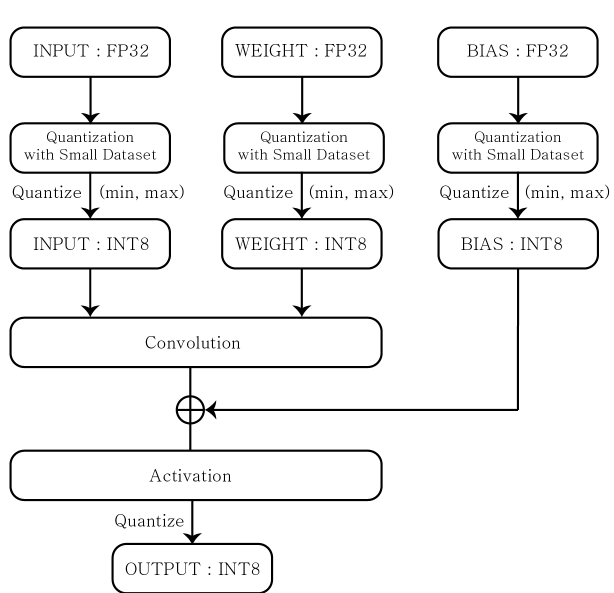
Figure 4. Full Integer